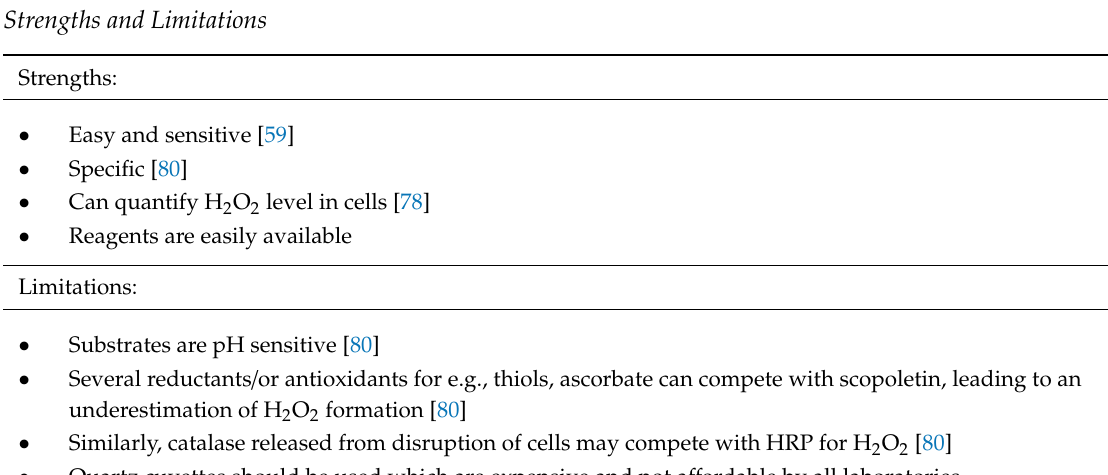
Figure 10. H 2 O 2 reaction mechanism.